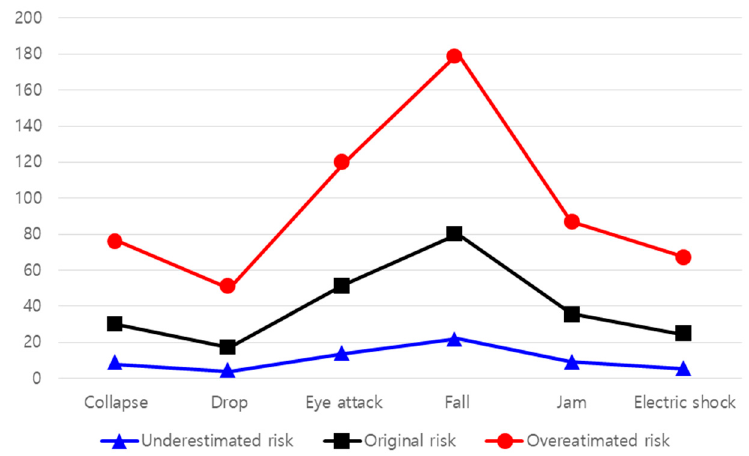
Figure 5. Sensitivity analysis on structural/job risks by work-risk type.